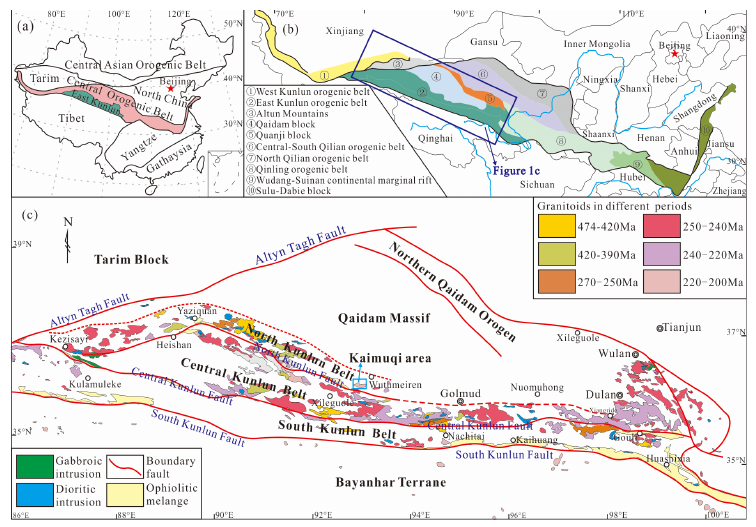
Figure 1. ( a ) Tectonic map of China (modified after [31]). ( b ) Location and tectonic map of the Central Orogenic Belt in China (modified after [31]). ( c ) Schematic geological map of the Eastern Kunlun Orogen showing the distributions of igneous rocks in the Phanerozoic and the location of Kaimuqi area (modified after [32]). The strata in the EKO include Precambrian metamorphic rocks and volcanic–sedi ‐ mentary rocks formed in the Phanerozoic various periods [30]. The Precambrian meta ‐ morphic rocks are mainly granulite ‐ facies metamorphic rocks of the Paleoproterozoic Jinshuikou Group and greenschist ‐ facies metamorphic rocks of the Meso ‐ to Neoperote ‐ rozoic Wanbaogou Group, among which the former constitutes the crystalline basement of the North Kunlun Belt and the Central Kunlun Belt, while the latter is the basement of the South Kunlun Belt [21,22]. Phanerozoic strata are mainly continental margin volcanic– sedimentary clastic rocks, carbonates and continental volcanic rocks [33]. The continental margin volcanic–sedimentary rocks, which underwent epimetamorphism, developed mainly in the Ordovician–Silurian, Devonian, Carboniferous, Permian and Triassic strata, including basic–acid volcanics, volcanic breccia, tuff, conglomerate, sandstone, sand ‐ slate, silty phyllite, limestone and marble [23,32,33]. The continental volcanic rocks are hosted in the Late Devonian Maoniushan Formation and Late Triassic Babaoshan and Elashan Formations, including andesite, andesitic breccia, rhyolite, dacite, rhyolitic tuff and dacitic tuff [21,30,33]. The EKO experienced tectonic movements and developed structures with different scales and mechanical properties, such as E–W ‐ trending deep faults (e.g., North, Central and South Kunlun faults) and their secondary NW ‐ trending faults [2,3,21,22,24,29,30]. The E–W ‐ trending deep faults constitute the structural framework of the EKO and play a sig ‐ nificant role in controlling the distribution of strata, magmatic rocks and ore deposits. Due to the superposition of the multistage marginal orogeny, the distribution of geological bodies in the EKO is disordered with poor continuity [34]. The EKO recorded multiple intense magmatic events that formed numerous suites of mafic–felsic igneous rocks during various phases of magmatism, especially within the